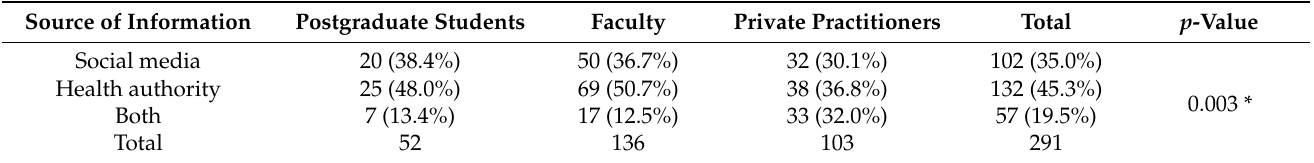
Table 1. Comparison of the source of information utilized for COVID-19 among the pediatric dentist.